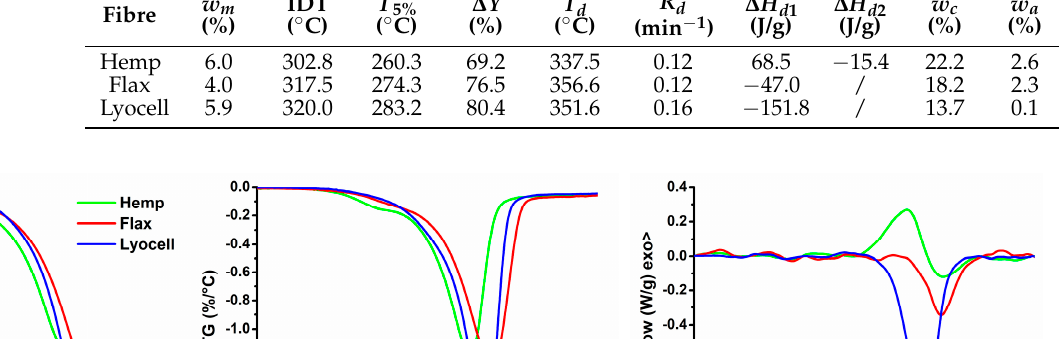
Table 4. Thermal properties of hemp, flax and Lyocell fibres determined using TGA/DSC. Fibre